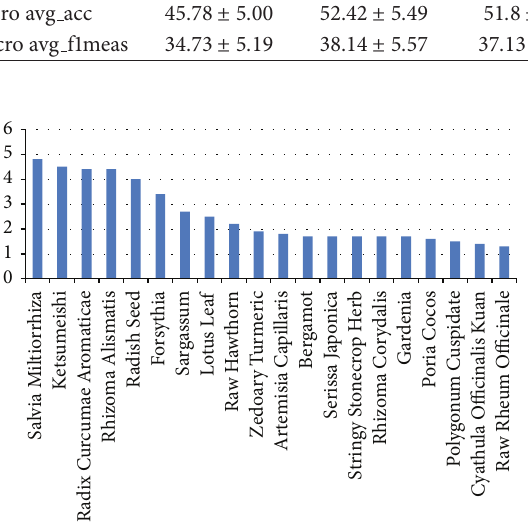
Figure 8: The first 20 most frequently used herbs and their normalized frequency.